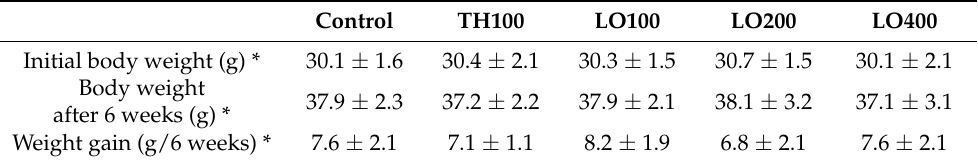
Table 2. Effect of different doses of C. osmophloeum ct. linalool leaf oil on the body weight gain of ICR mice after 6 weeks of oral administration.